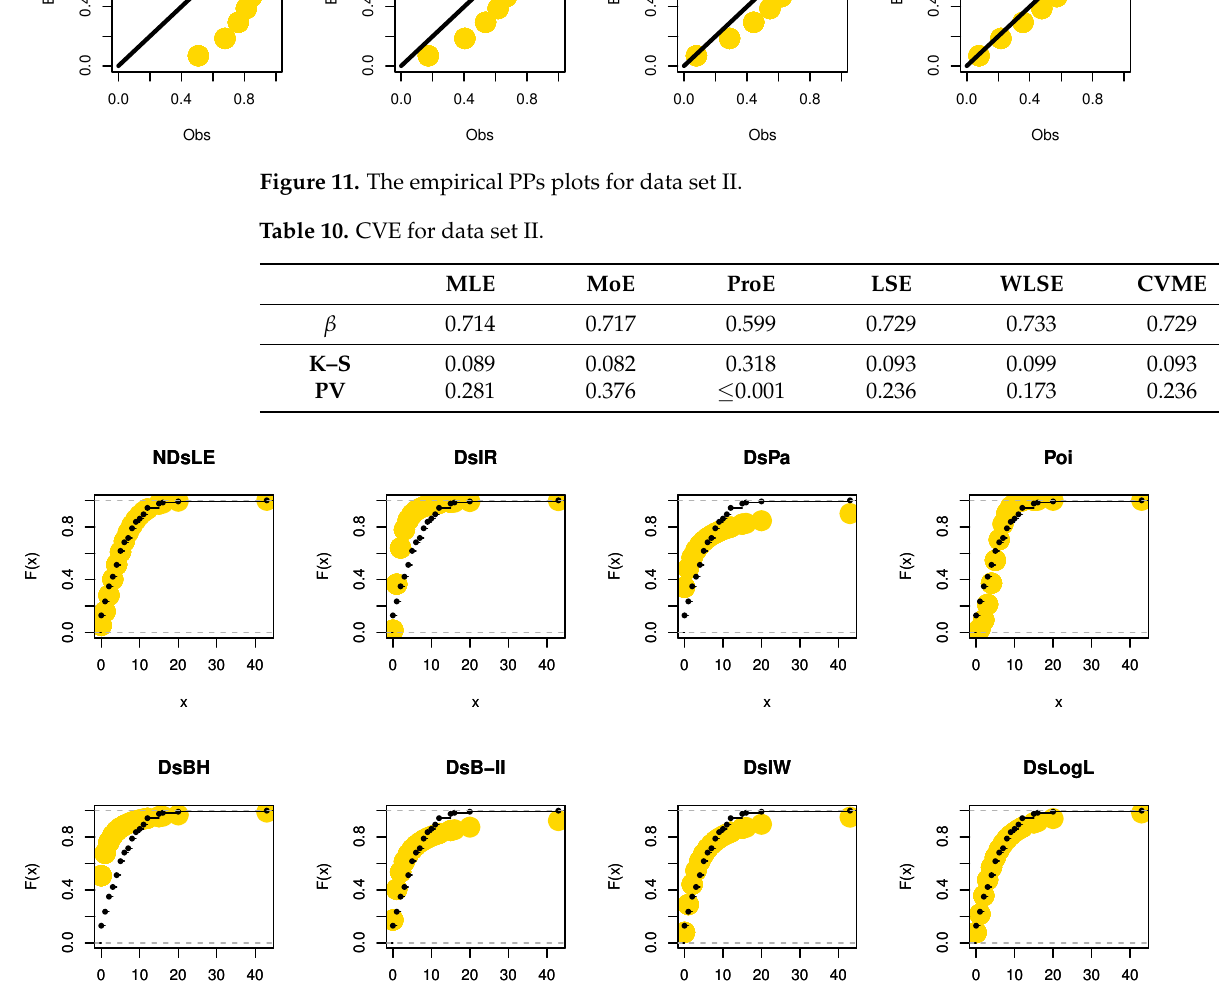
Figure 12. The empirical CDFs plots for data set